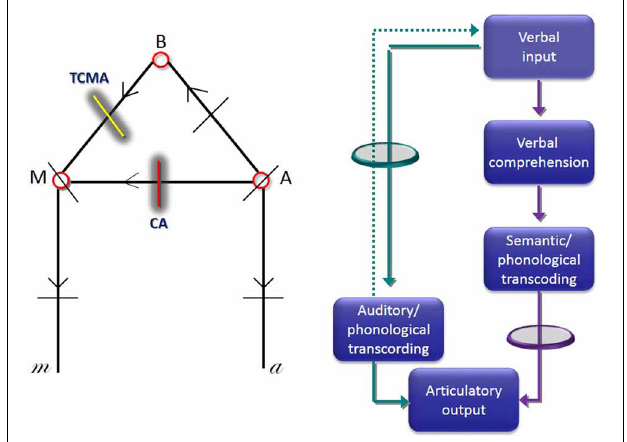
FIGURE 1 | Lichtheim’s first diagram of speech centers, commissural pathways and predicted sites of lesions that would cause aphasia (left image). In this diagram, “A” indicates the center of auditory images, “M” the center of motor images, and “B” the center of concepts. Lesions interrupting the commissure “A”-“M” cause conduction aphasia (CA) (red line), whereas interruption of the commissure interconnecting B-M causes transcortical motor aphasia (TCMA) (yellow line). Diagram depicting a two route model to repetition (right image) (adapted from McCarthy and Warrington, 1984). The green circle represents the route that should be interrupted to induce CA, whereas the purple circle represents a lesion in the connection that should be interrupted to induce